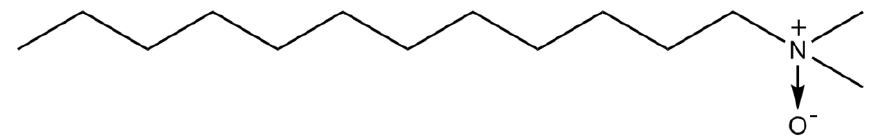
Figure 7. Structure of dodecyldimethylamine oxide (LDAO) (chemical formula is C 14 H 31 NO).